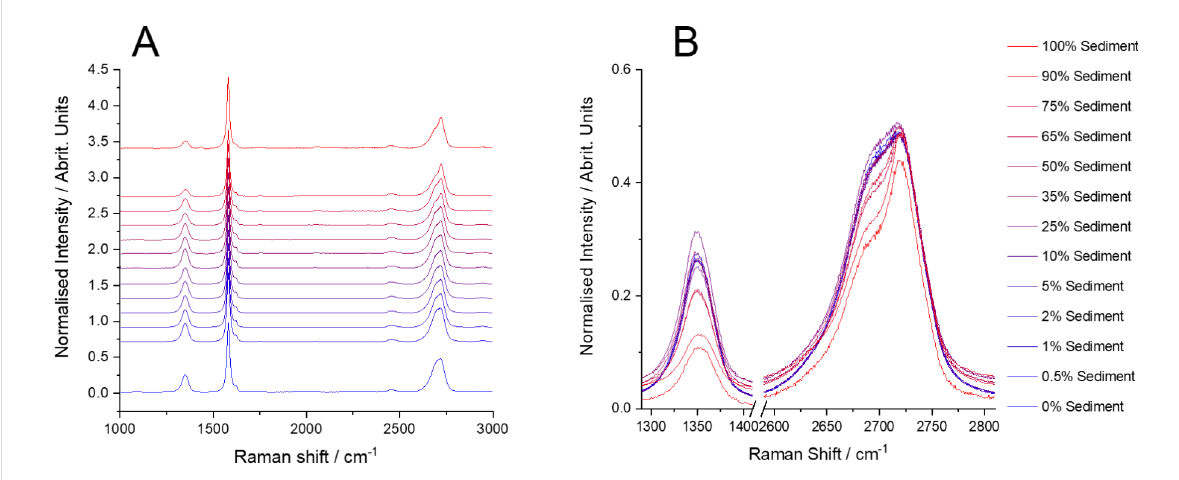
Figure 6: (A) Averaged spectra from samples of GNP ref with additions of sediment. Bottom spectrum (blue) is sediment only. Top spectrum (red) is GNP ref only. All other spectra are mixtures of GNP ref and sediment. (B) Overlaid spectra showing the region of the D peak and the 2D peak.